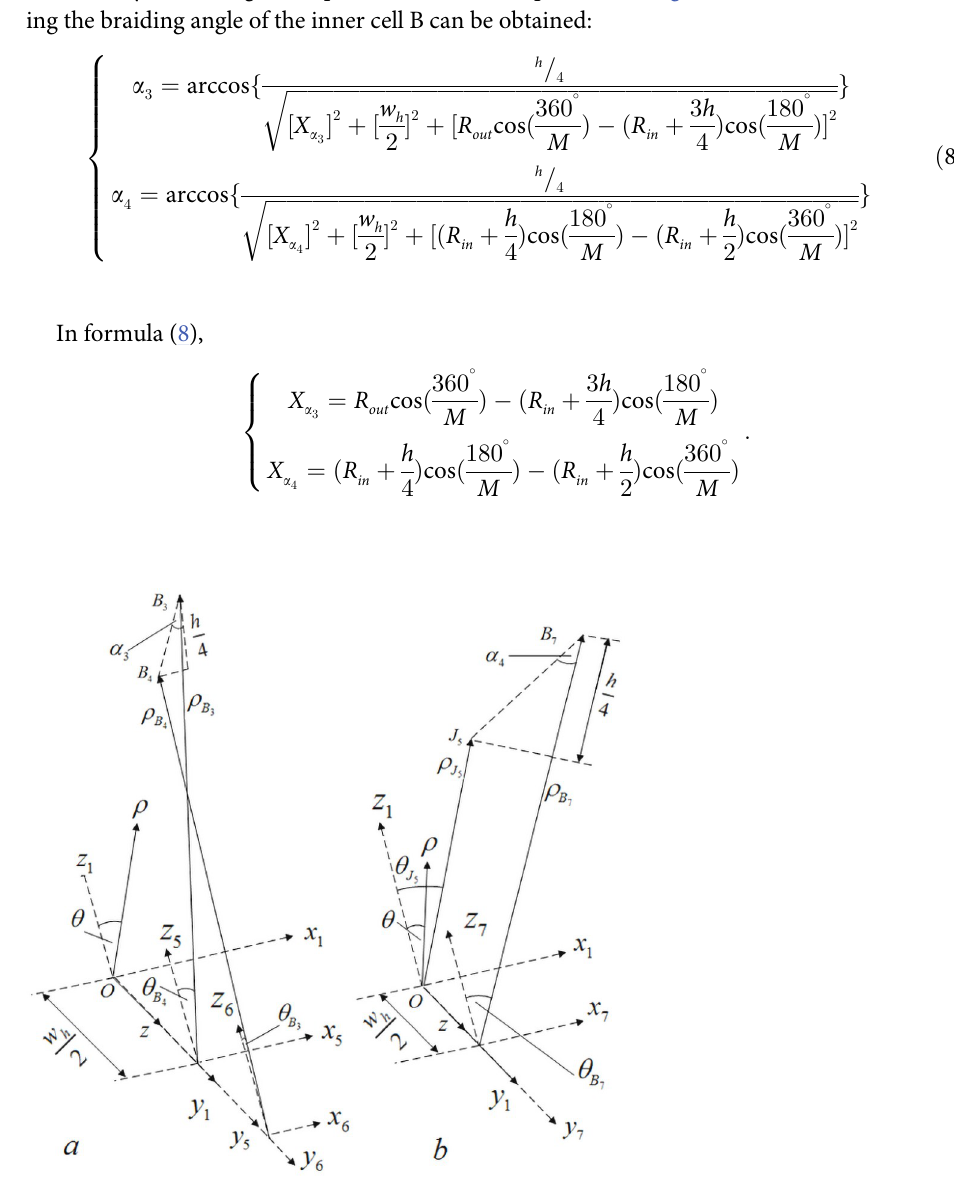
Fig 9. Calculation of braiding angle of internal cell